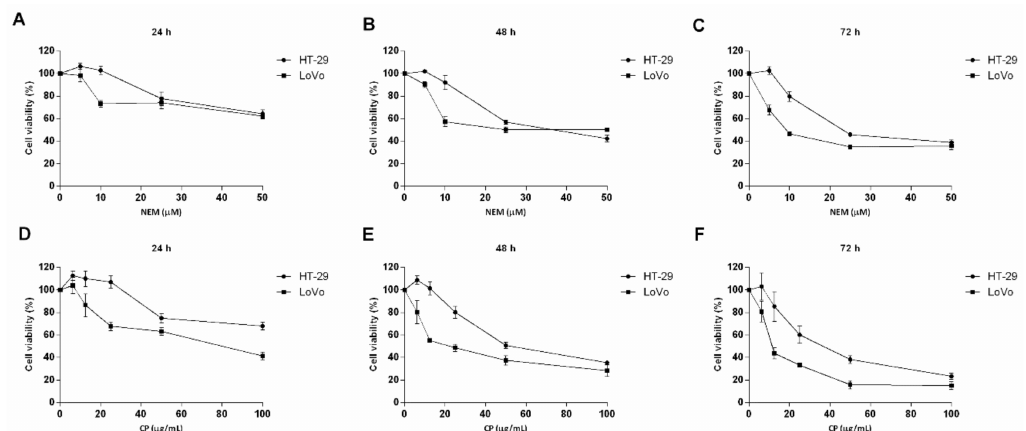
Figure 1. E ff ect of NEM and CP on CRC cell viability. HT-29 and LoVo cells were exposed to increasing concentrations of NEM ( A – C ) and CP ( D – F ) for 24, 48 and 72 h. Data are presented as mean ± S.D. of three independent experiments.